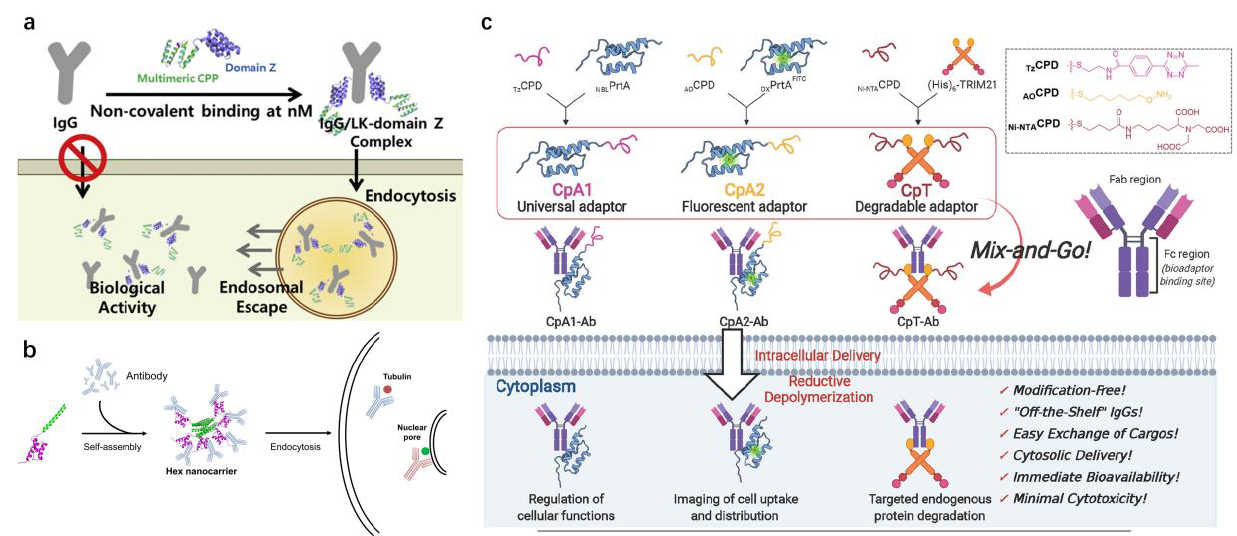
Figure 3. Examples for the intracellular delivery of antibodies based on affinity motif. ( a ) Schematic illustration of the working principle for the intracellular delivery of antibodies at nanomolar con- centrations by combination of domain Z and the multimers of LK sequences. Reproduced with permission from Ref. [60]. Copyright 2021 Journal of Controlled Release. ( b ) Schematic illustration of the working principle of the Hex nanocarrier that combines specific protein–protein interactions and nanoparticle benefits. Reproduced with permission from Ref. [61]. Copyright 2017 Journal of Controlled Release . ( c ) Schematic illustration of the working principle of the “mix-and-go” approach for CPD-facilitated cytosolic delivery of native functional antibodies with immediate